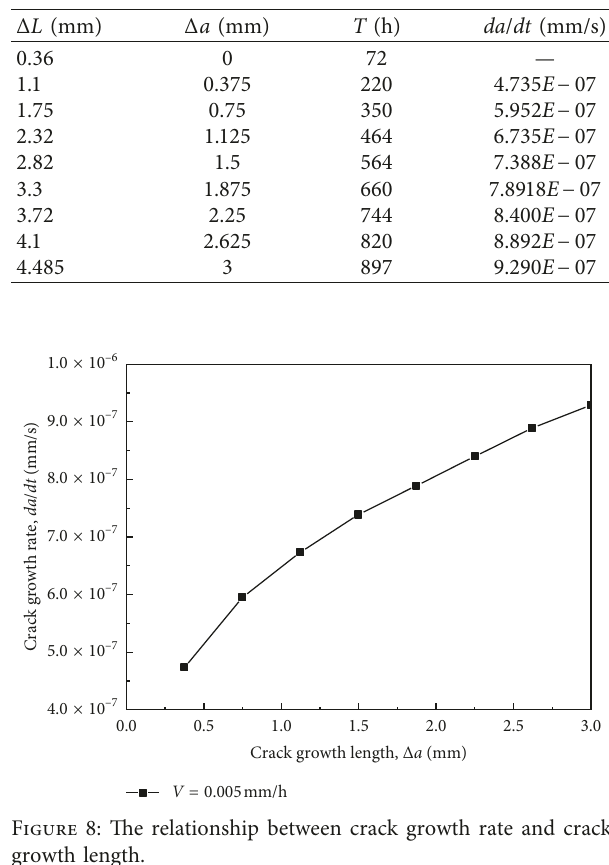
Figure 10: The J -integral along the thickness of